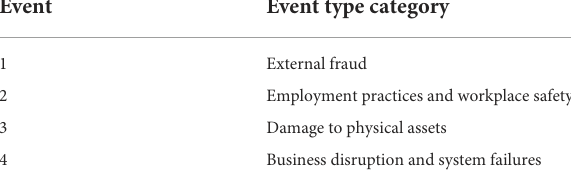
TABLE 1 Event type category (level 1) of selected